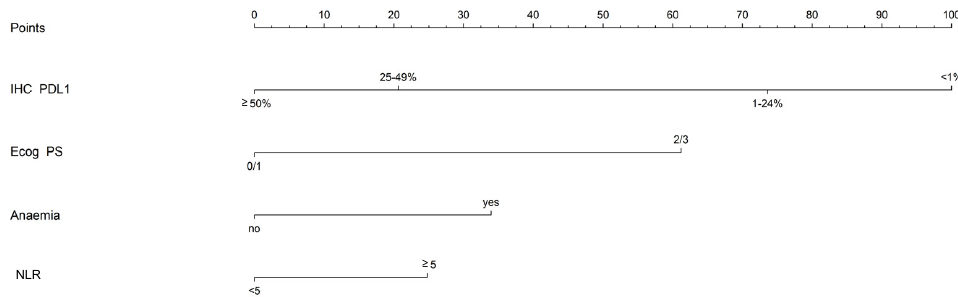
Figure 1. Nomogram for PFS prediction. Each variable’s value is associated with a score (points bar on the upper part of the nomogram, Supplementary Table S4). By summing the points corresponding to the different variables included, it is possible to calculate the subject’s total score.